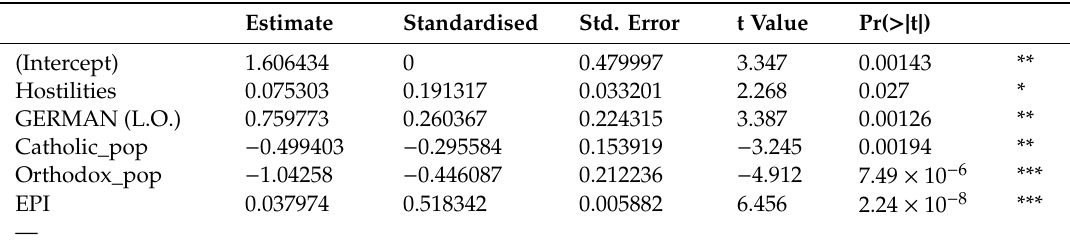
Table 11. Model 5. Competitiveness in Europe and the Americas (Step method) (Author’s figure). Estimate Standardised Std.